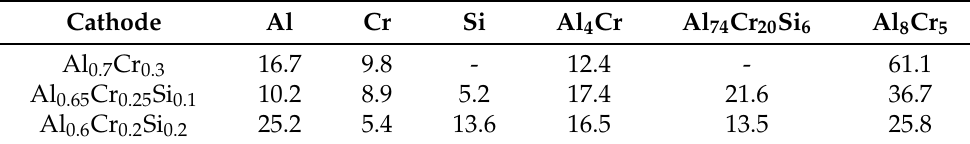
Table 1. Phase composition of the modified layer (vol.%).